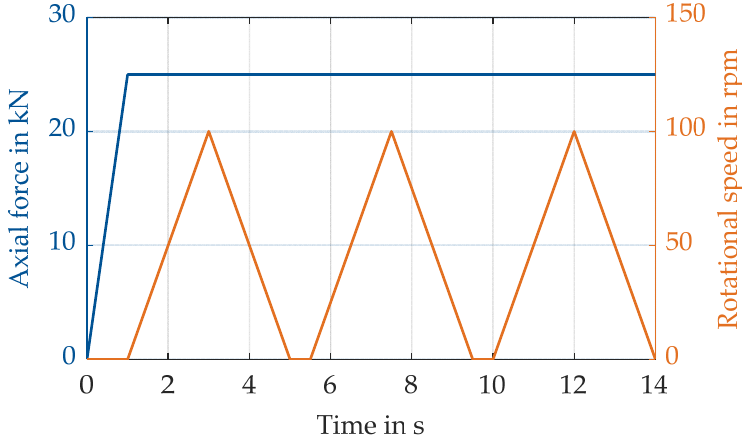
Figure 4. Exemplary curve of the axial force and differential rotational speed [20].